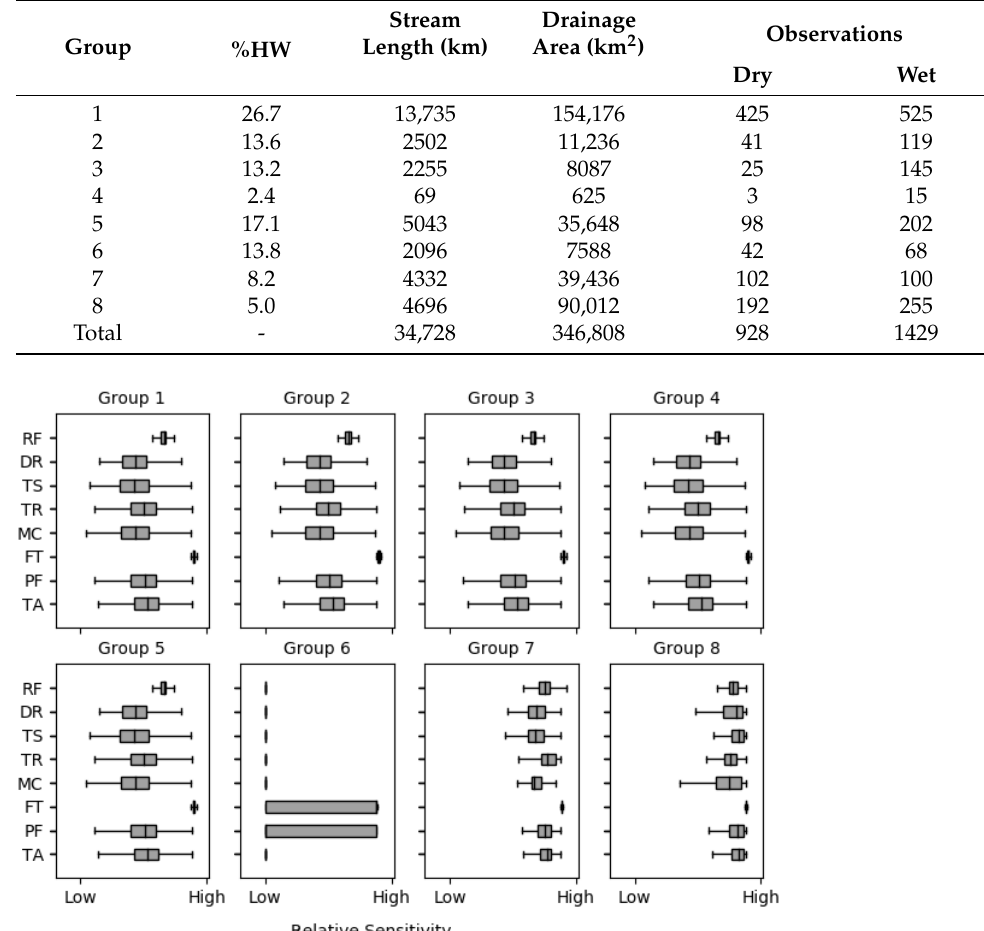
Table 2. Number of wet and dry surface water presence observations used to calibrate the monthly water balance model for each calibration group, where %HW is the percentage of the 1.3 million headwater stream reaches within the study area assigned to each group, stream length is the total length of streams in each calibration group and drainage area is the total area drained by streams in each calibration group.